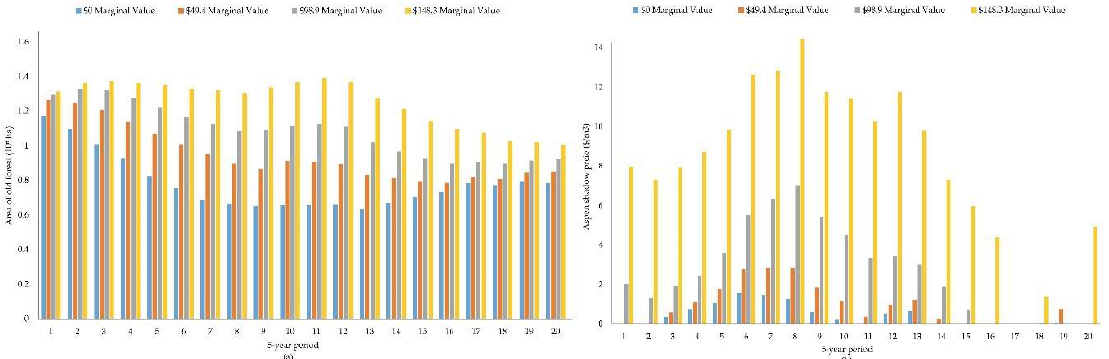
Figure 7. Amount of old forest produced under the horizontal marginal value functions ( a ) and marginal values associated with the aspen volume constraints ( b ).